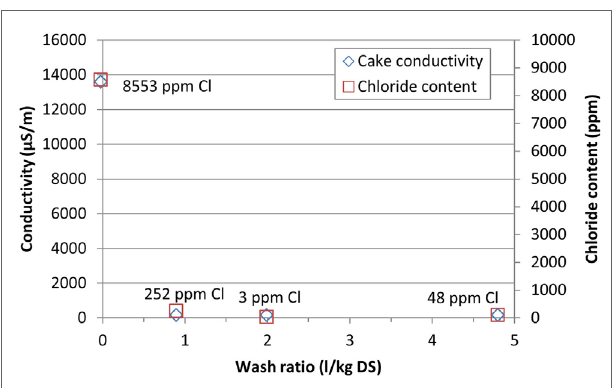
FigUre 8 | conductivity and final chloride content of the calcite cake with vacuum filtration using different wash ratios